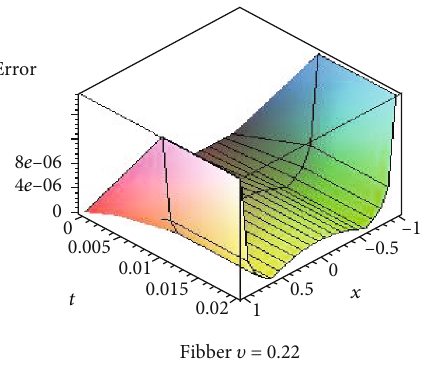
Figure 4: The value absolute error by TMM at N = 20 and T = 0 : 02 .